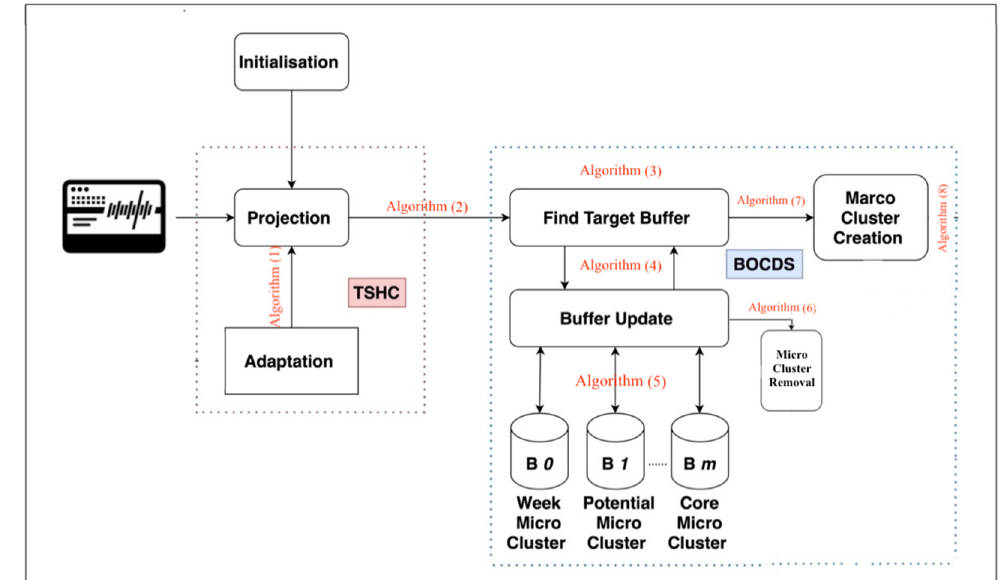
Figure 3. Online Clustering Algorithm developed.